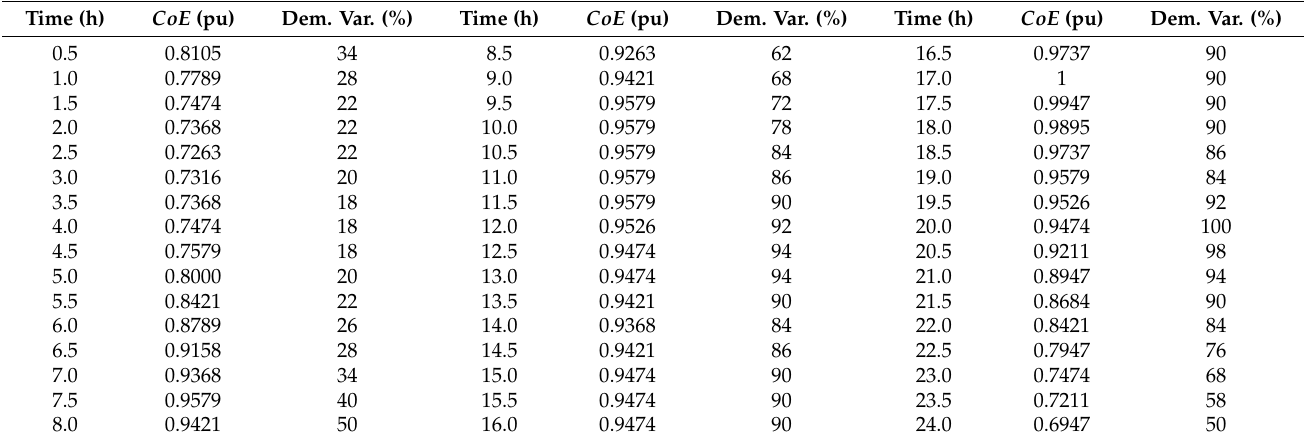
Table 3. Hourly demand behavior and energy buying costs.